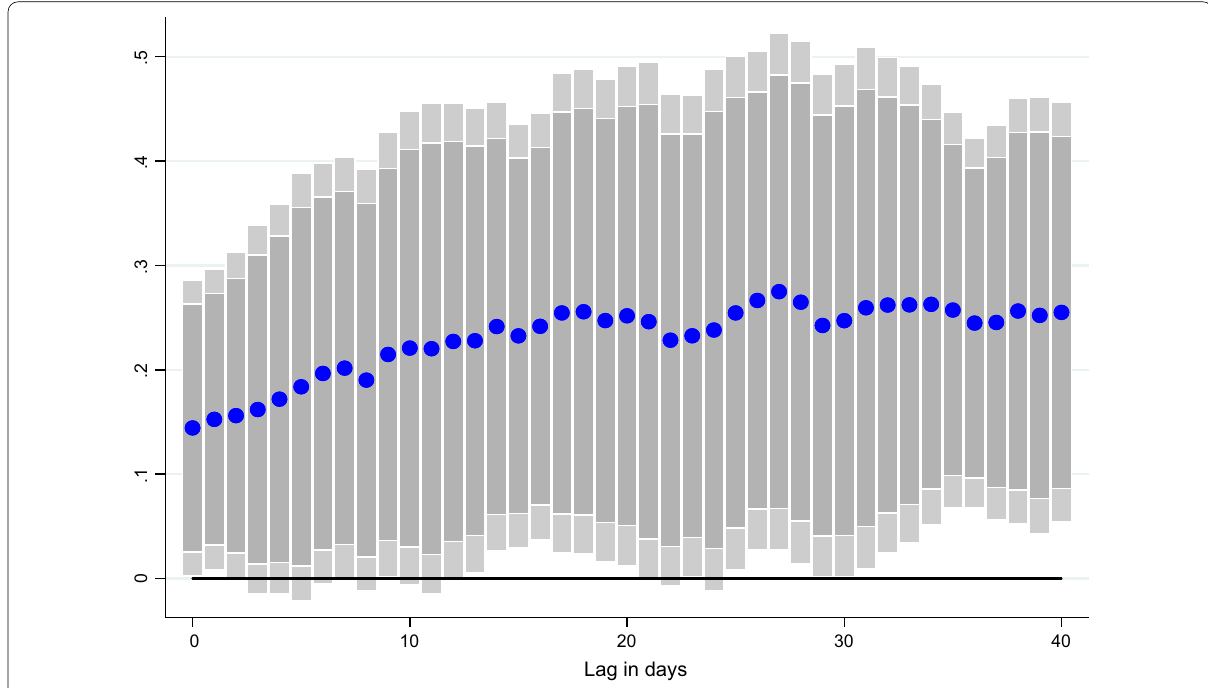
Fig. 7 Effect of US COVID-19 vaccinations on economic activity. Coefficient γ is reported for each lag ℓ (1–40), and based on � Y i , t = α + µ i + γ t + β SV i , t − l + γ TradingPartner j , t − m + θ X i , t − l + ε i , t for a sample of 43 countries using daily data from December 20, 2020–June 16, 2021. where